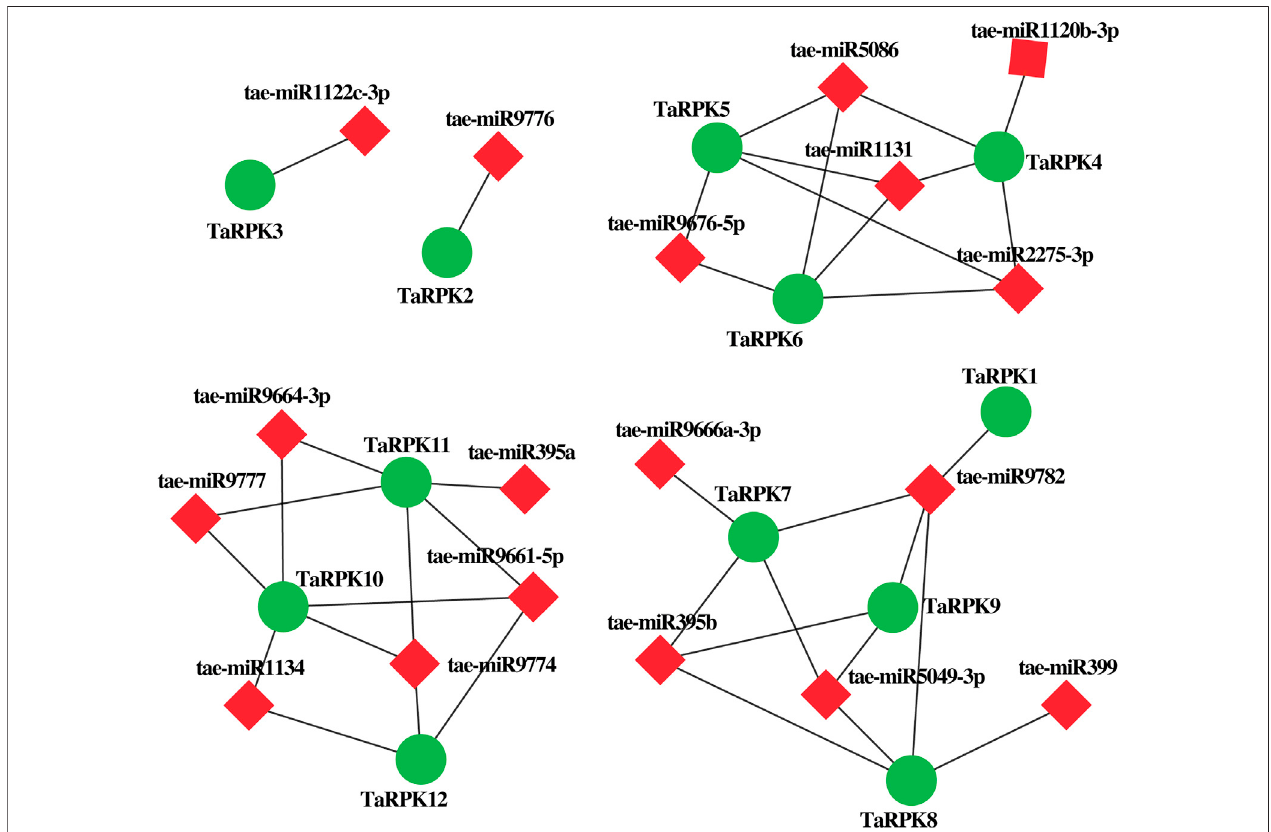
FIGURE 5 | MicroRNA and their targeted TaRPK1 genes. Regulatory network relationship between miRNA and their targeted TaRPK1